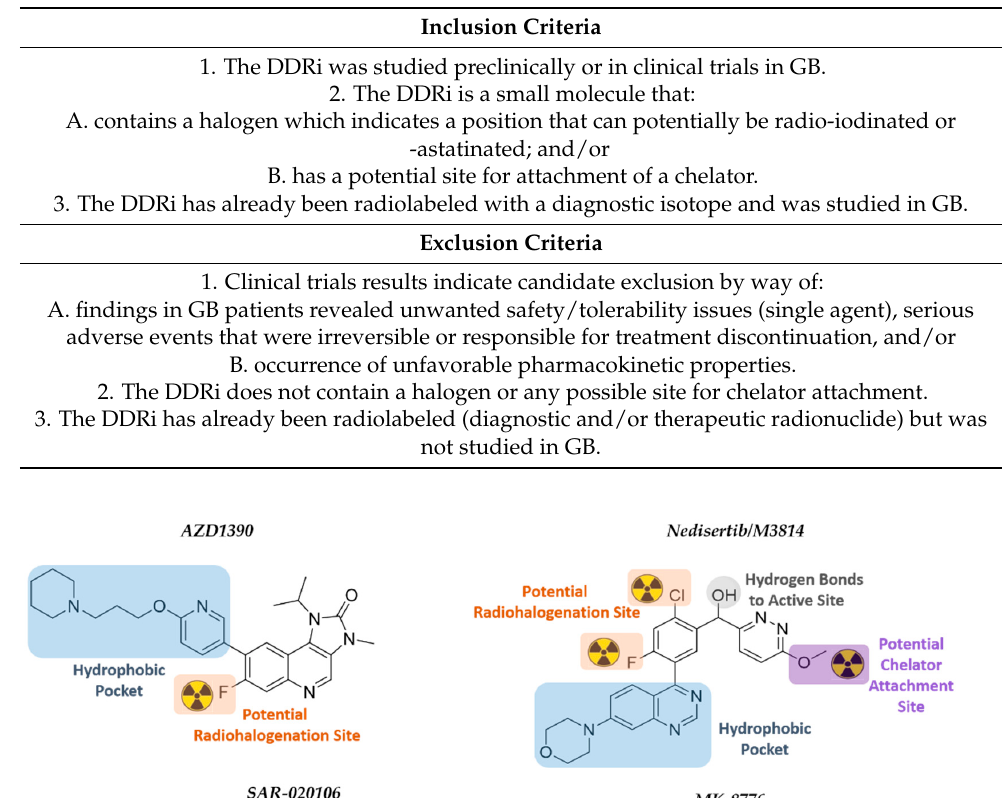
Table 2. Selection criteria for assessment of candidate GB DDRi TRT agents.